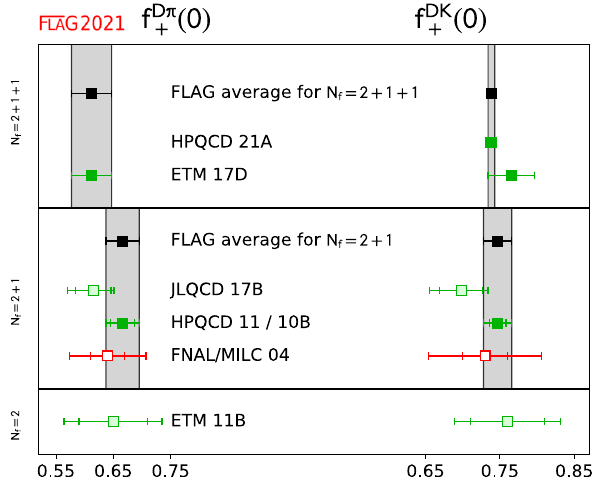
Fig. 23 D → π(cid:6)ν and D → K (cid:6)ν semileptonic form factors at q 2 = 0. The N f = 2 + 1 HPQCD result for f D π + ( 0 ) is from HPQCD 11, the one for f DK + ( 0 ) represents HPQCD 10B (see Table